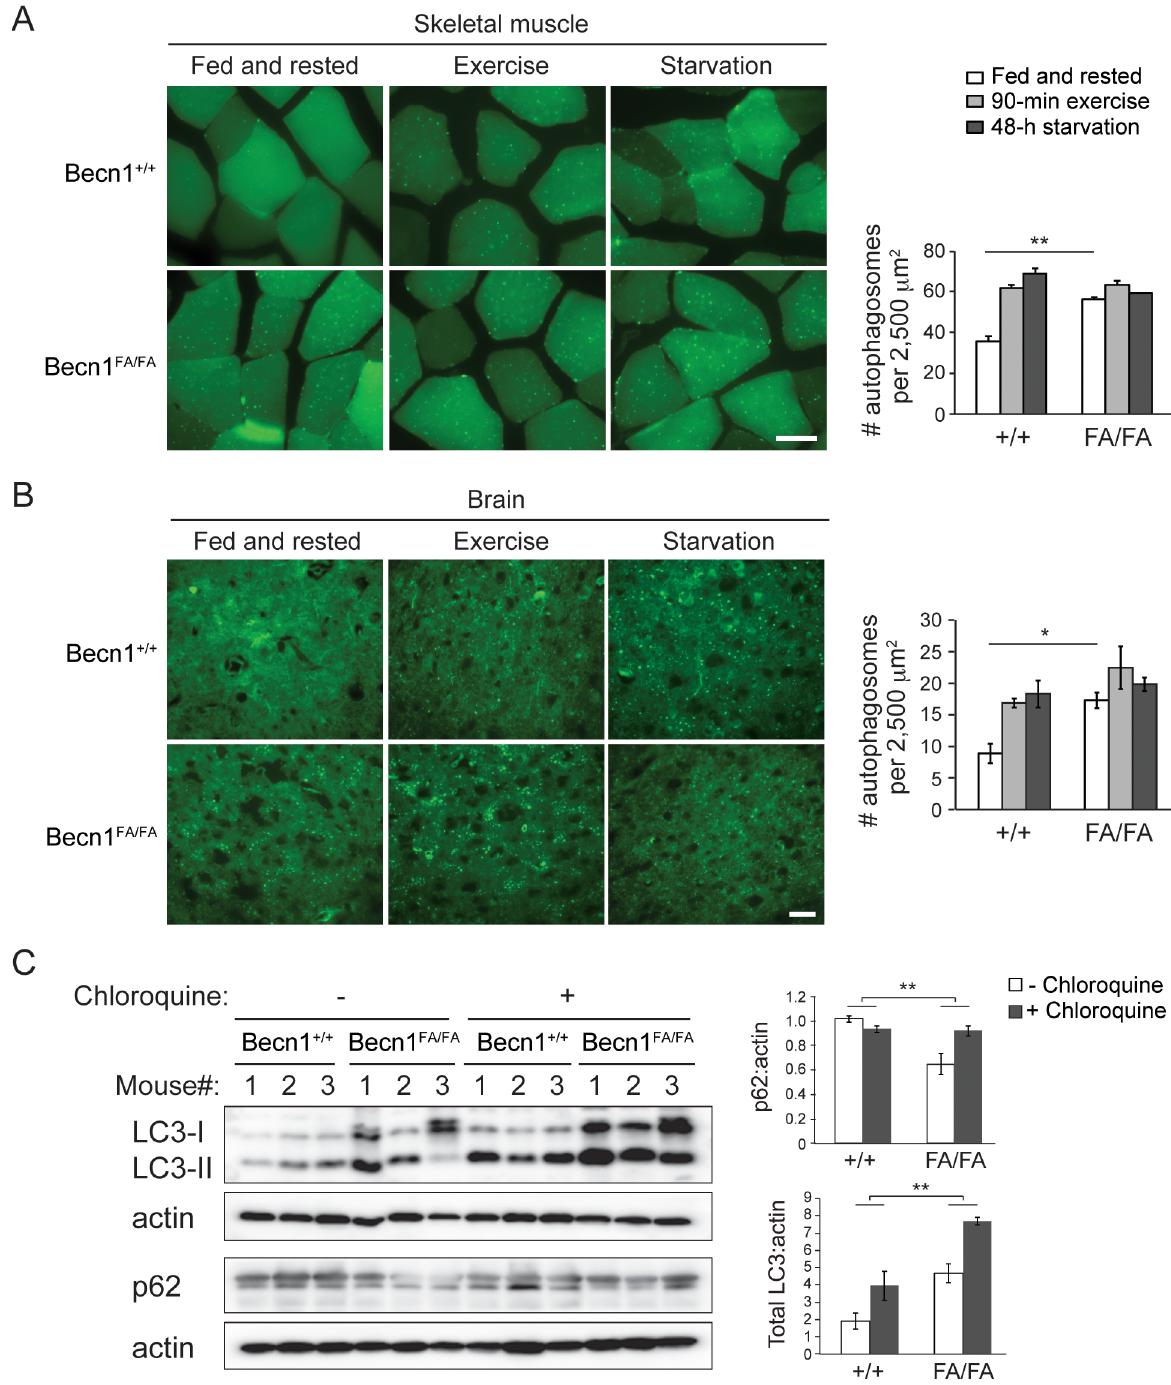
Fig 2. Becn1 F121A leads to autophagy hyperactivation in vivo. (A, B) Representative images (left panel)and quantification (right panel)of GFP-LC3 puncta (autophagosomes)in skeletal muscle (A) and brain (B) of GFP-LC3 Becn1 +/+ and GFP-LC3 Becn1 FA/FA mice at non-autophagy-inducingconditions (fed and rested), after 90-min exercise, or after 48 hours of starvation. Scale bar: 25 μ m. Results represent mean ± s.e.m. N = 5. * , P < 0.05, ** , P < 0.01, t test. (C) Western blot analysis(left panel) and quantification(right panel)of LC3 and p62 levels in skeletal muscle from Becn1 +/+ and Becn1 FA/FA mice injected with one dose of PBS or 50 mg/kg lysosomalinhibitor chloroquine.The autophagyflux is measuredby the difference in the p62 and LC3 levels betweenmice injected with PBS and with chloroquine.Results represent mean ± s.e.m. N = 3. ** , P < 0.01,two-way ANOVA for comparisonof magnitude of changesbetween different groupsin mice of different genotypes.